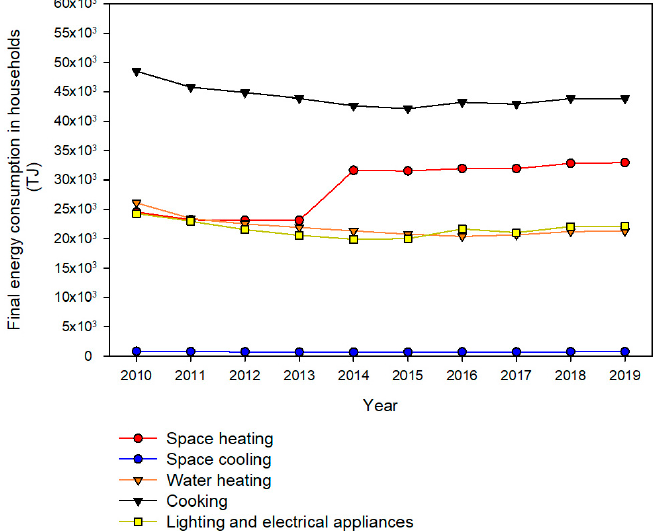
Figure 3. Households’ energy consumption by use (data source [45]).